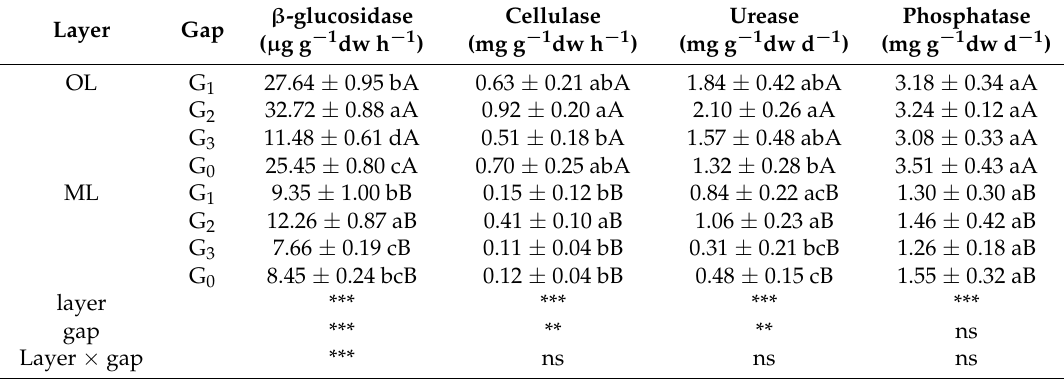
Table 4. Soil enzyme activities in the organic and mineral soils from the four treatments. Values are the mean ± standard deviation (n =